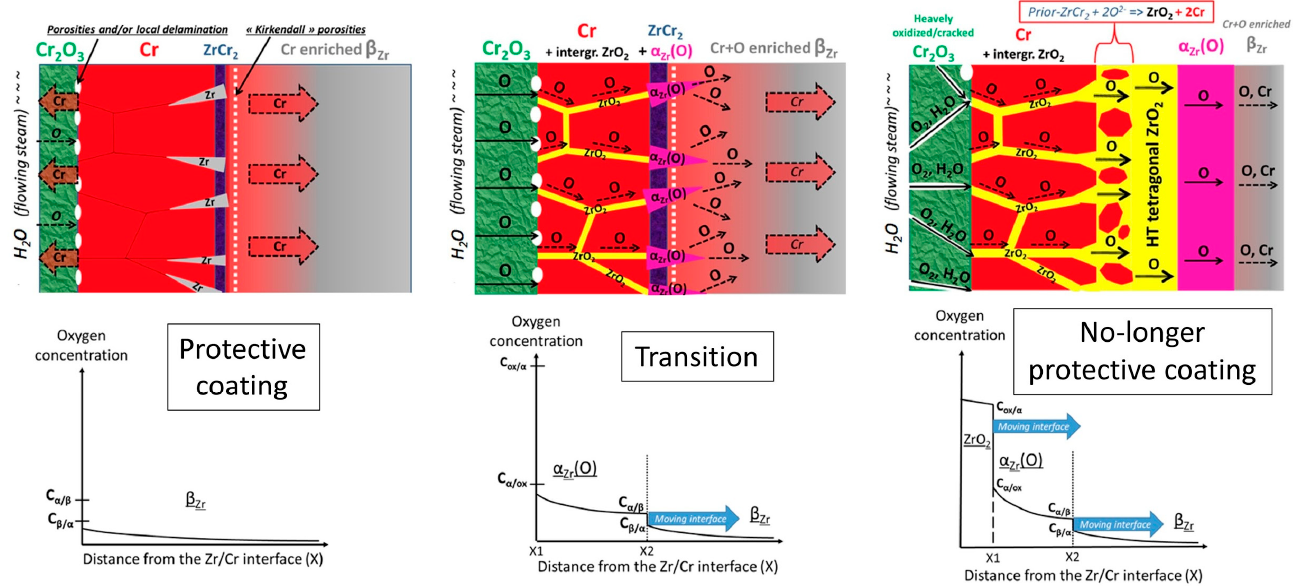
Figure 13. Schematic overview of the HT steam oxidation process of Cr-coated zirconium-based alloy. Replotted from [166] with permission by Elsevier.